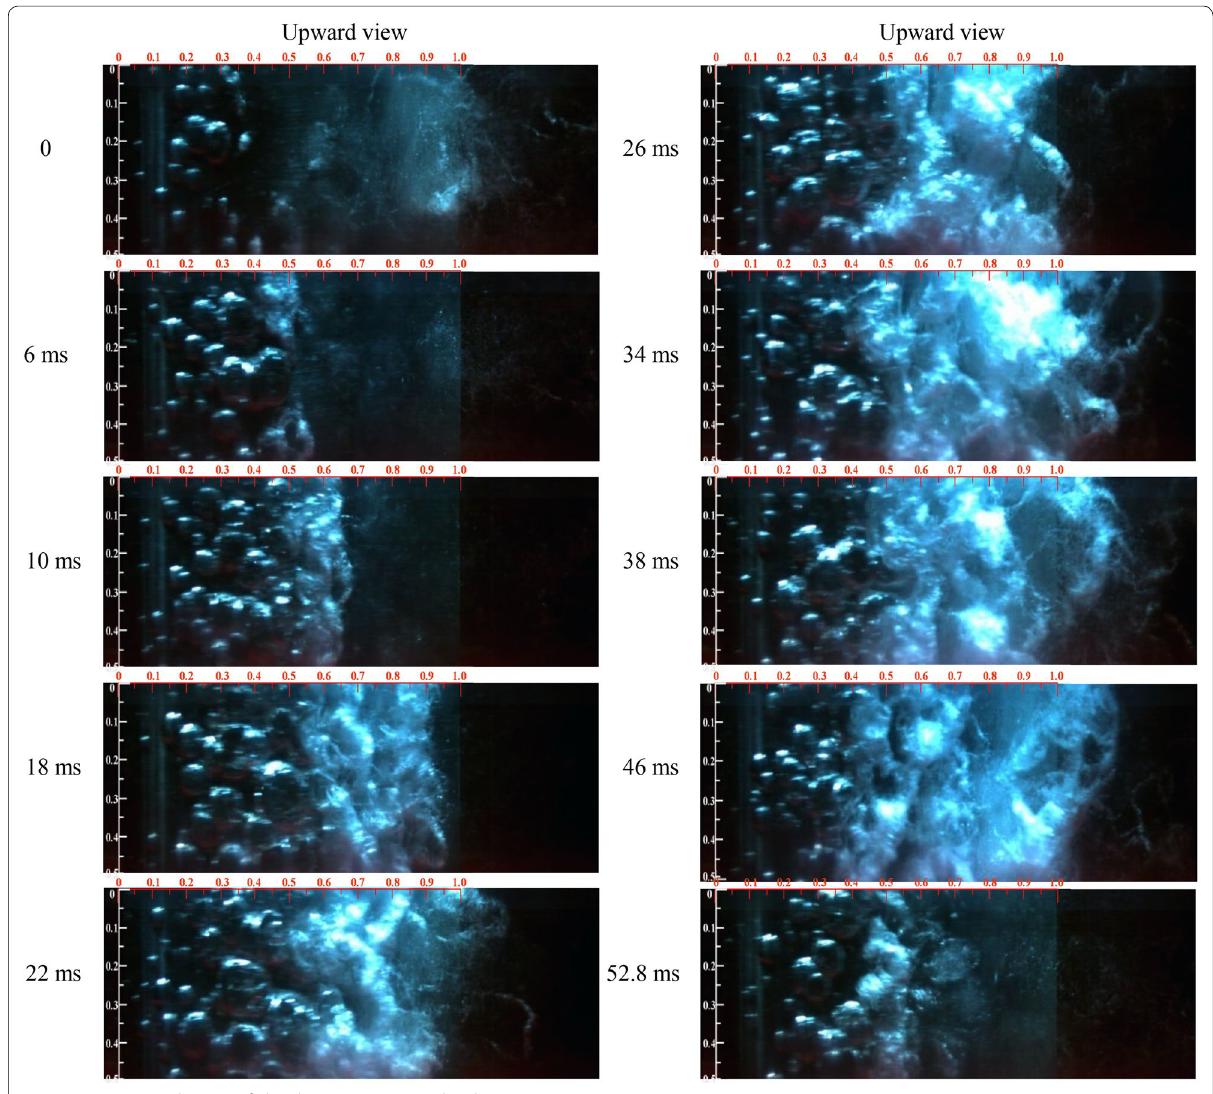
Figure 9 Time evolutions of cloud cavitation around Foil B ( σ